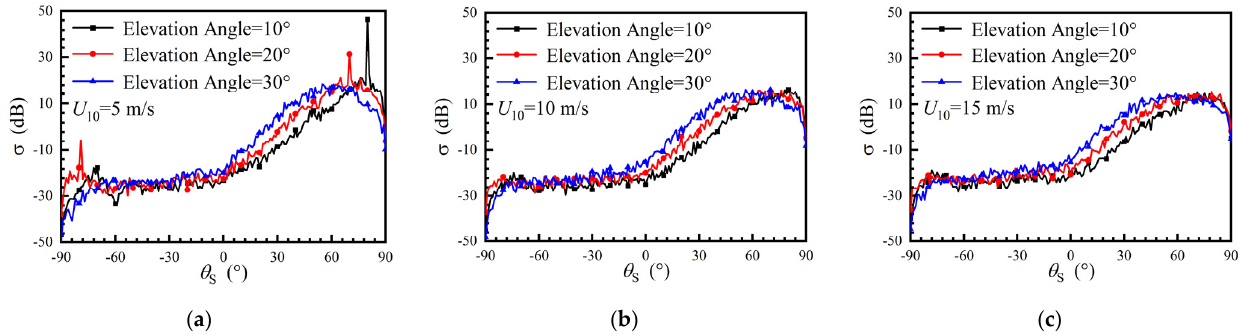
Figure 2. The variations of the bistatic scattering coefficients with the scattering angle for B1I signals at the satellite elevation angle of 10 ◦ (black line with square symbols), 20 ◦ (red line with circular symbols), and 30 ◦ (blue line with triangular symbols) under the wind speed: ( a ) 5 m/s; ( b ) 10 m/s; and ( c ) 15 m/s.